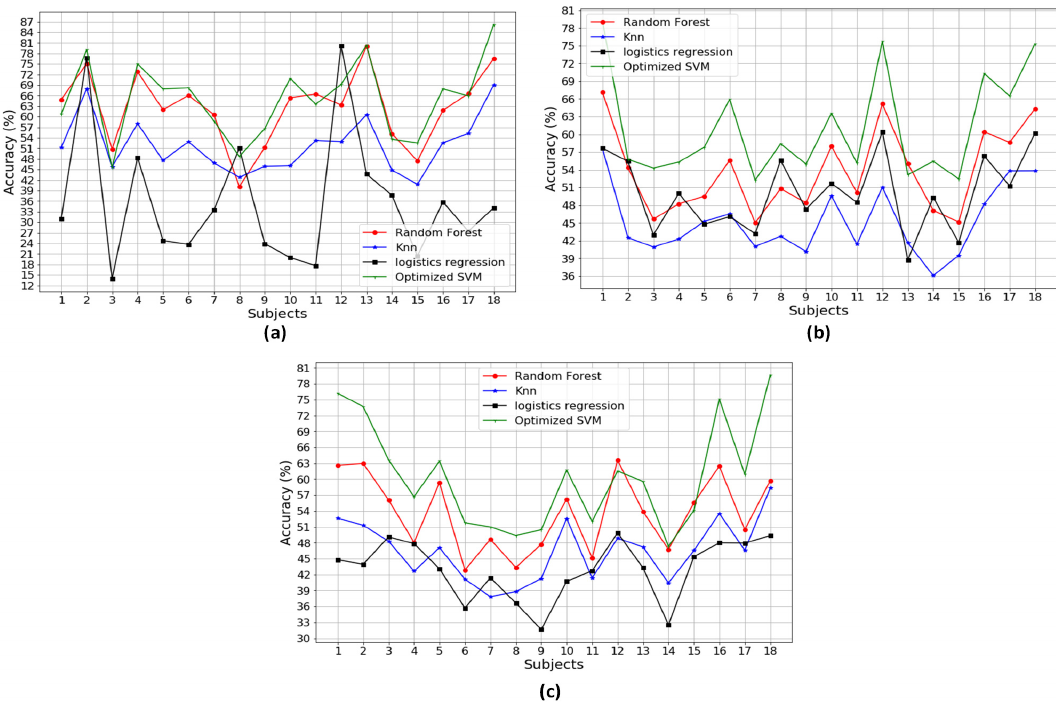
Figure A5. The average accuracy performance over individual types of sensors: ( a ) accuracy over pressure sensor; ( b ) accuracy over accelerometer; and ( c ) accuracy over gyroscope.